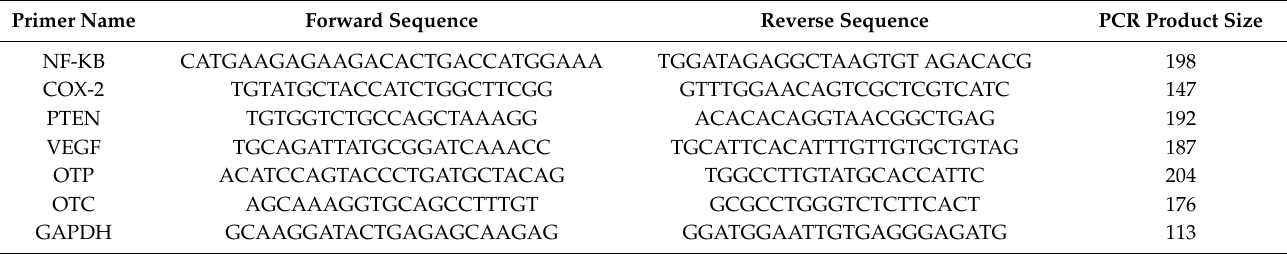
Table 1. Primers used in